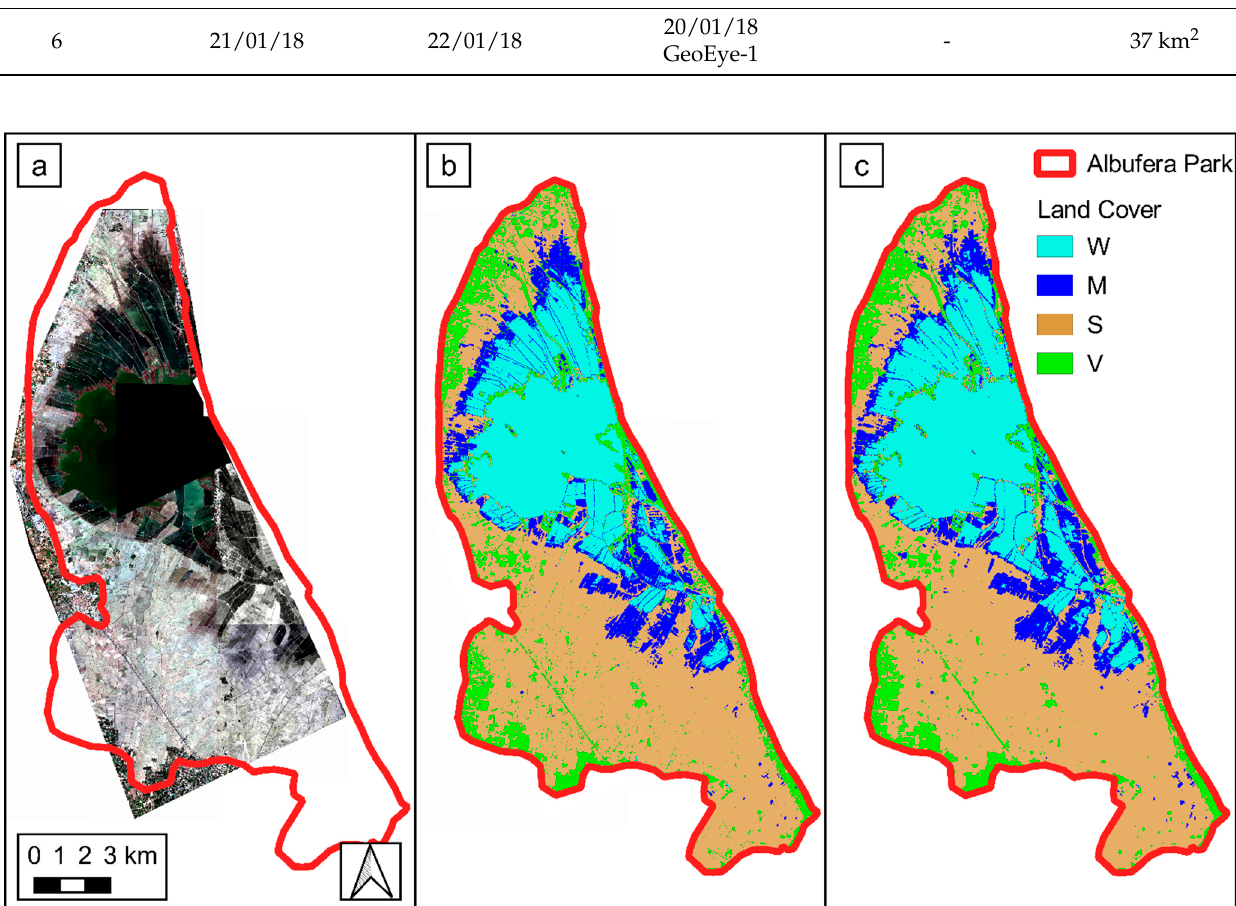
Figure 5. ( a ) RGB GeoEye-1 of 14 February 2020 provided by ESA (© TPMO 2020); ( b ) Land cover classification extracted by S2 image of 15 February 2020; ( c ) Land cover classification extracted by L8 image of 13 February 2020.